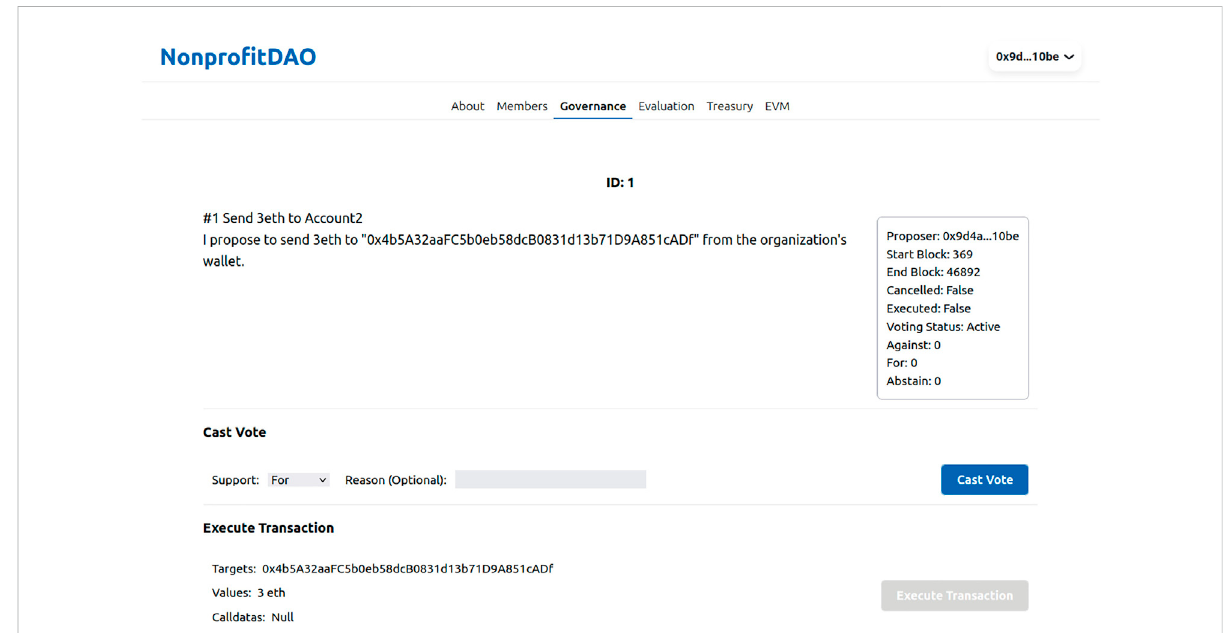
FIGURE 6 The proposal details section in the front-end software. Since the status is marked as Active, members can vote by selecting For, Against, or Abstain, along with the